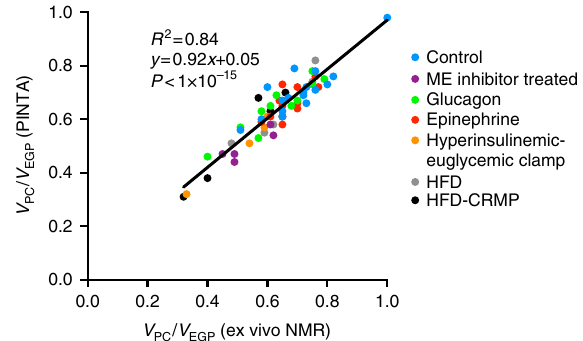
Fig. 2 V PC / V EGP ratios measured by PINTA and ex vivo NMR. This ratio correlates tightly when measured by PINTA with the V PC / V EGP ratio determined using ex vivo NMR